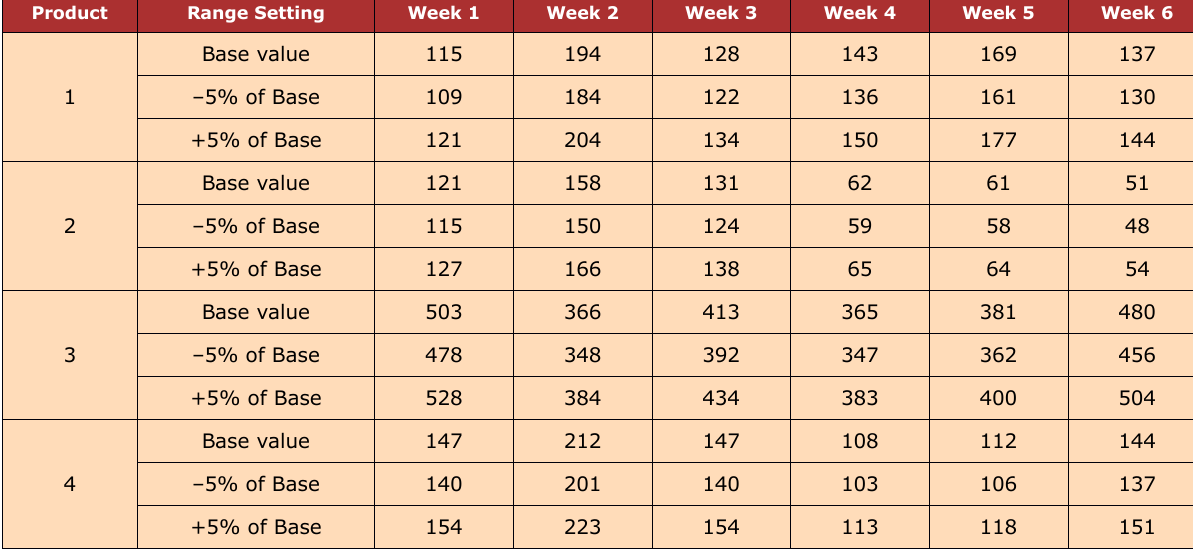
Table 18. Case-2 boundary conditions used in creating LHS samples demand data